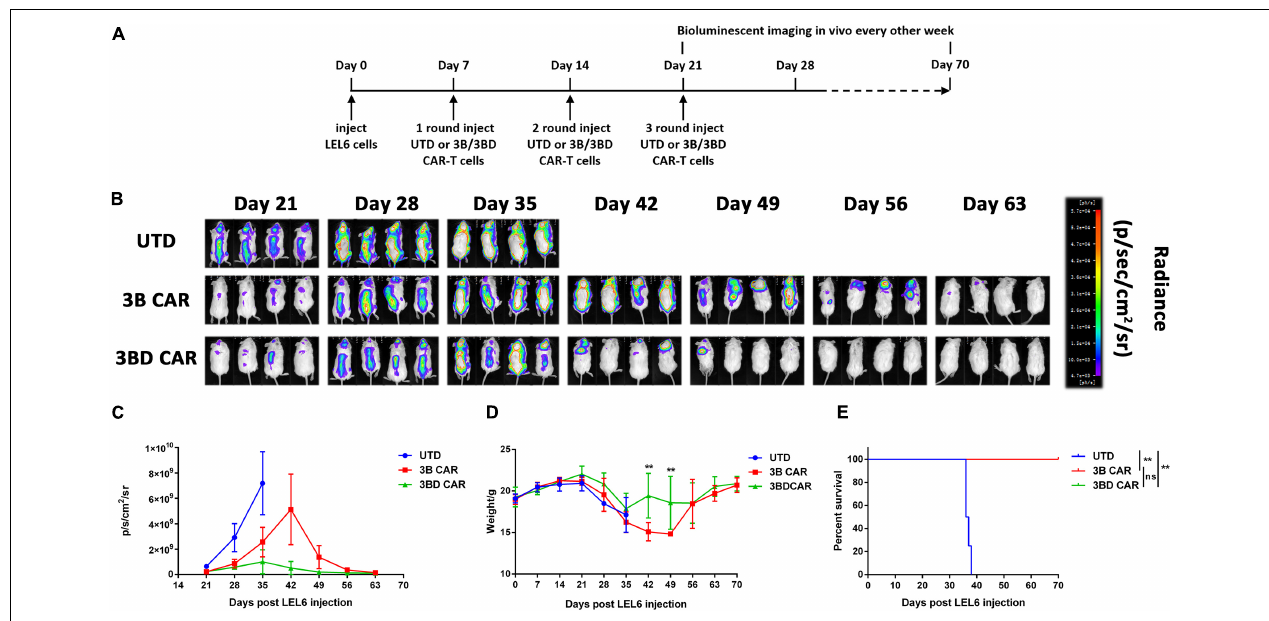
FIGURE 6 | 3BD CAR-T cells are more potent than 3B CAR-T cells in eliminating LEL6 cells in vivo . (A) Illustration of the experimental design. An HIV-1 Luc-Env + /PD-L1 + NCG mouse model was established in NCG mice by inoculating 1 × 10 5 LEL6 cells/mouse (i.v. by tail, n = 4). In the next 3 weeks, the mice were treated with 3B CAR-T cells or 3BD CAR-T cells 3 times. Mice treated with non-transduced T cells (UTD) served as the control. BLI was conducted after the mice were treated with the last single T cell injection (Day 21) and performed weekly. (B) LEL6 progression and distribution were evaluated by serial bioluminescence imaging. (C) Bioluminescence values of mice receiving different treatments are displayed. (D) Sequential body weight was analyzed every 7 days after LEL6 cell implantation. The significance shown is a comparison of each condition versus 3B CAR. Statistical analyses were performed by two-way ANOVA followed by Bonferroni post-test analysis. * p < 0.05, ** P < 0.01. (E) The survival of the mice was monitored. (** p < 0.01; log